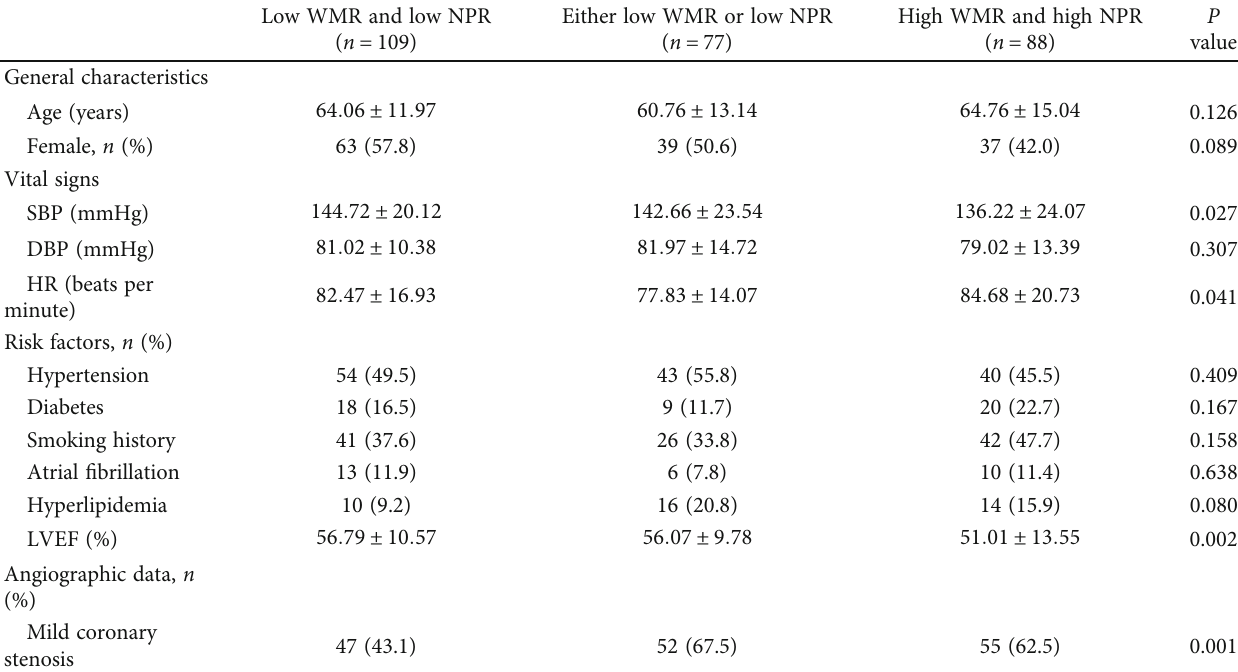
Table 1: Baseline characteristics based on the WMR and